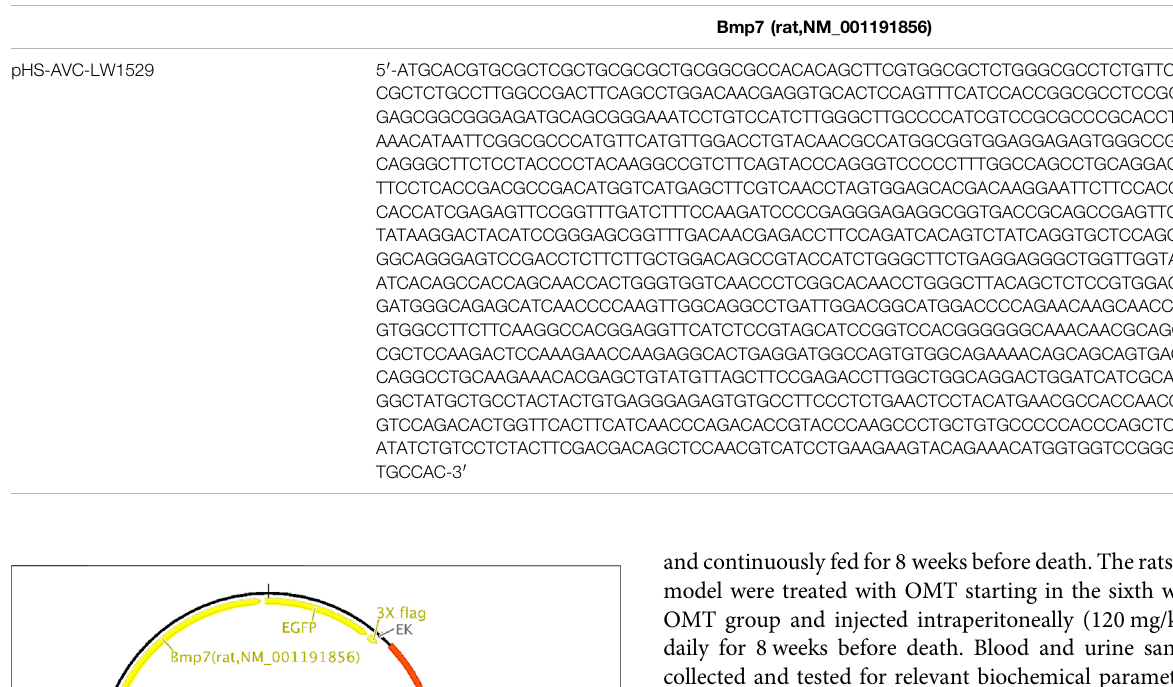
TABLE 1 | Virus sequence.